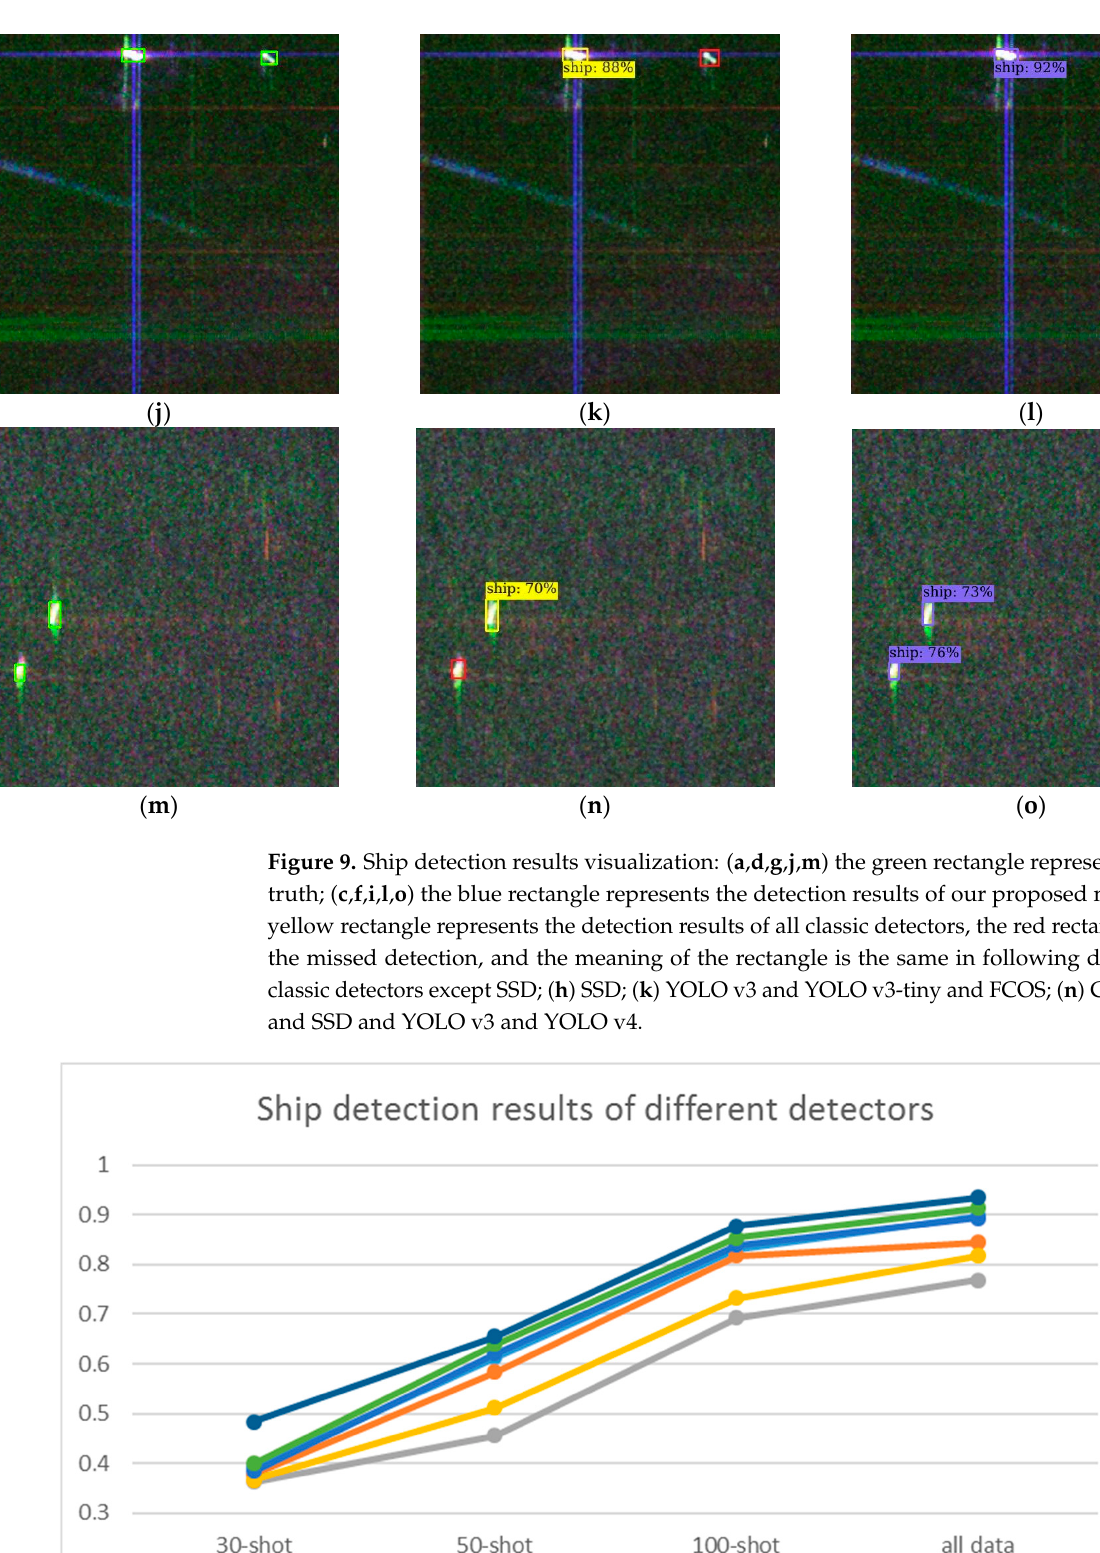
Figure 10. Ship detection results of different detectors and number of input samples.